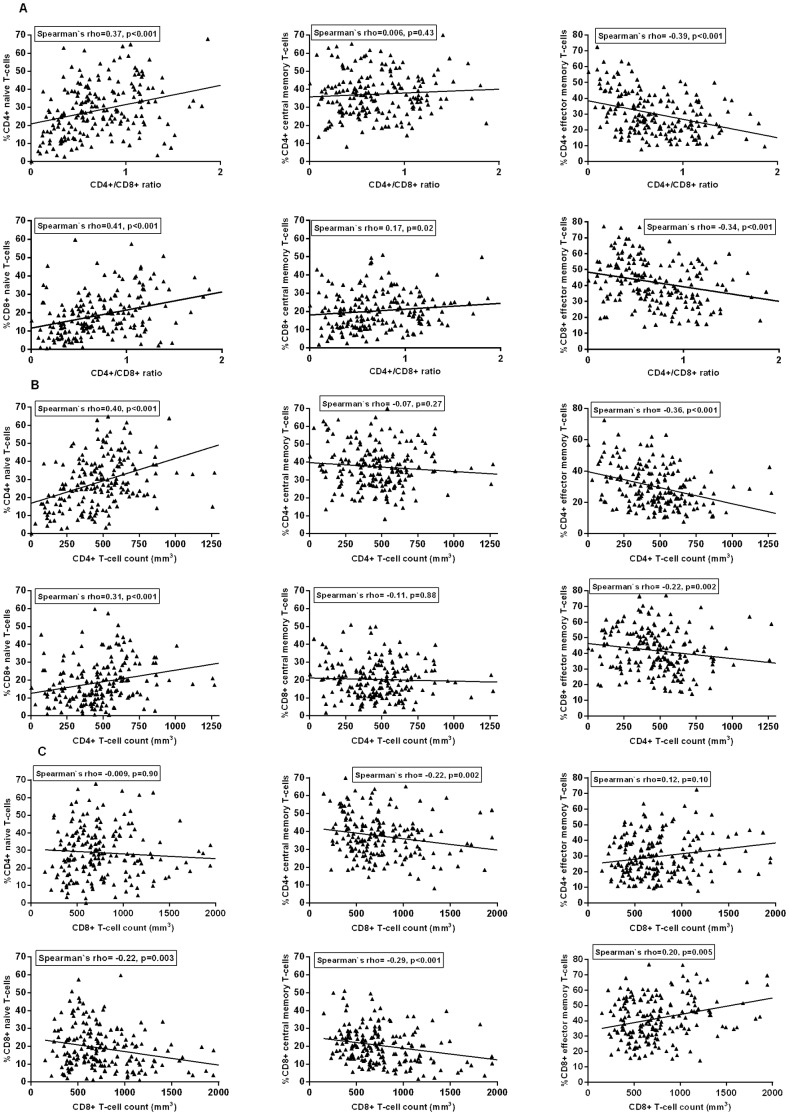
Correlation between CD4+ and CD8+ expanded T-cell subsets with CD4+/CD8, CD4+ and CD8+ T-cells.